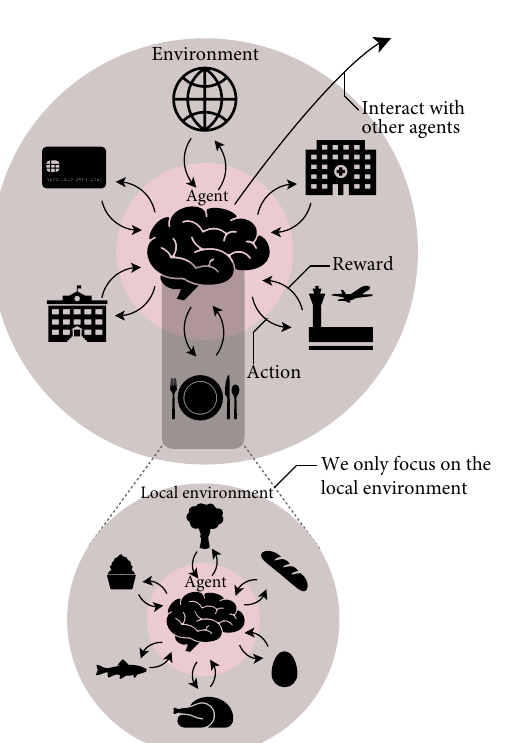
Fig. 1 Interaction mode between the agent and environment. The agent needs to choose an optimal action strategy independently to make the sum of rewards of all environmental factors feedback reach the optimal state. The research object of this paper is the subenvironment of dietary